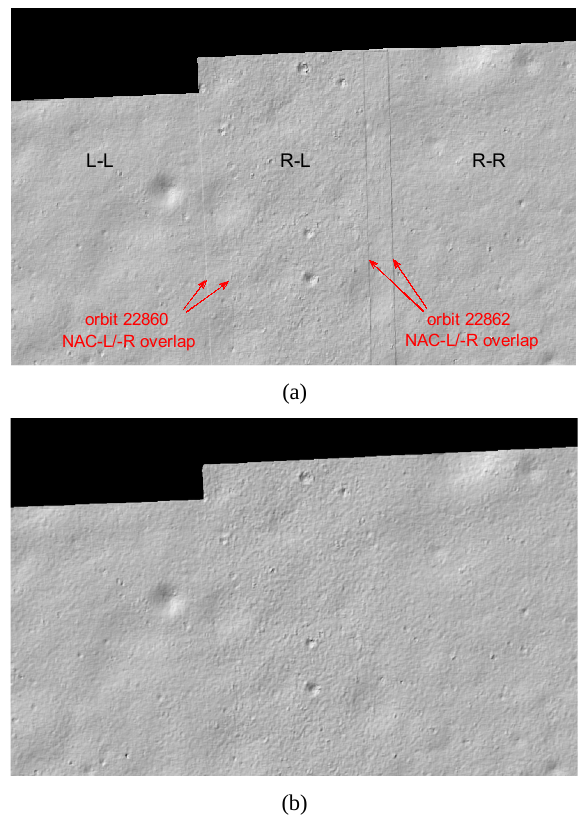
Figure 4: (a) Upper, central part of the NAC DTM (shaded) before adjustment. Errors in the exterior orientation result in height offsets of up to ~2.6 m at the edges of the stereo models. (b) After adjustment: Offsets at the model edges are minimized, and the models smoothly merge into each other.